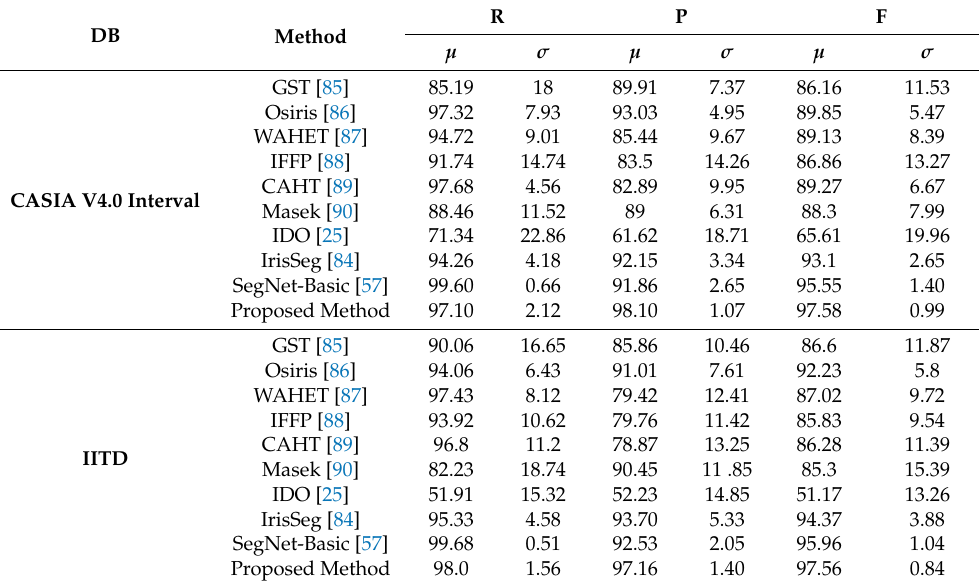
Table 7. Comparison of the proposed method with previous methods using CASIA v4.0 interval and IITD databases based on the RPF-measure evaluation protocol. A smaller value of σ and a higher value of µ show better performance. (unit: %) (The resultant values of GST [85], Osiris [86], WAHET